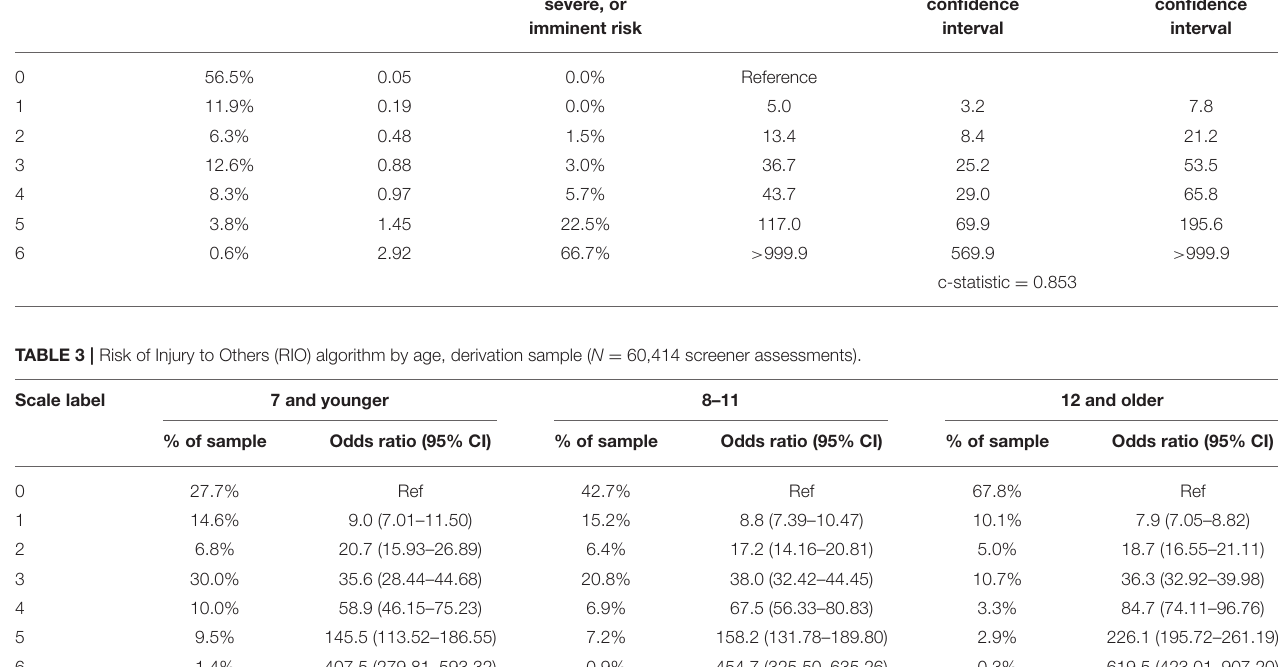
TABLE 2 | Validation results of Risk of Injury to Others (RIO) algorithm ( N = 2,117 screener assessments). Scale label